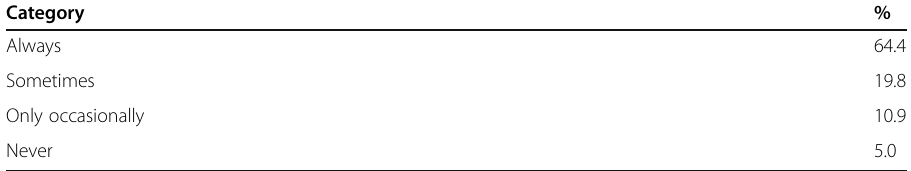
Table 4 Would you use test preparation material to prepare for